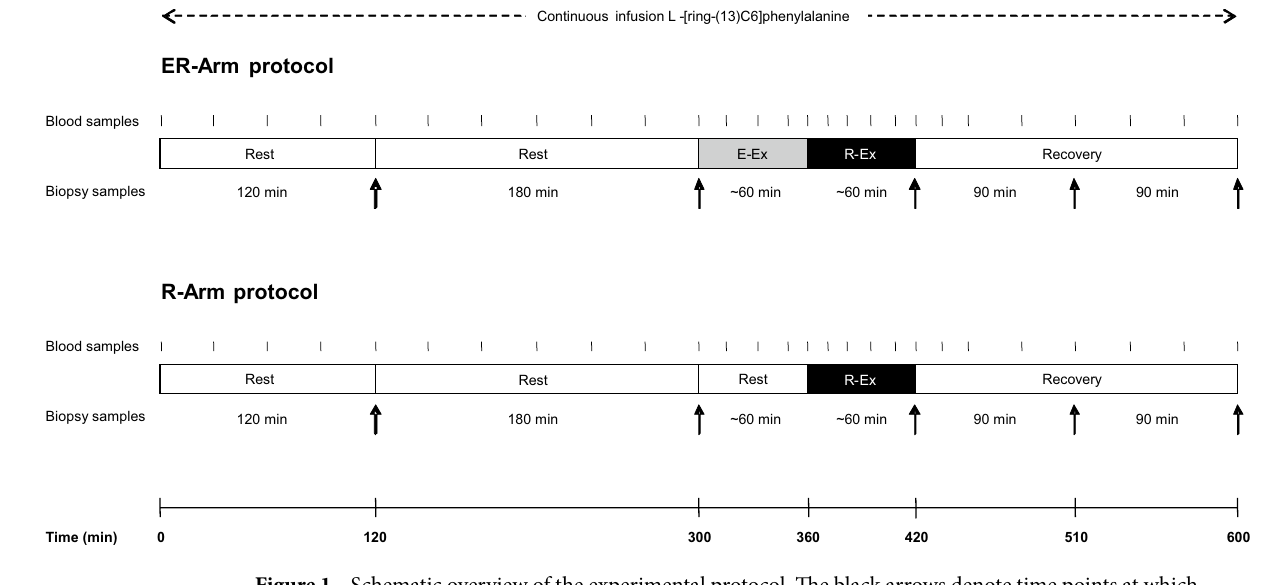
Figure 1. Schematic overview of the experimental protocol. The black arrows denote time points at which triceps brachii biopsies were taken and the small vertical black lines when blood was drawn. E-Ex: the high- intensity interval cycling; R-Ex: the resistance exercise involving seated arm